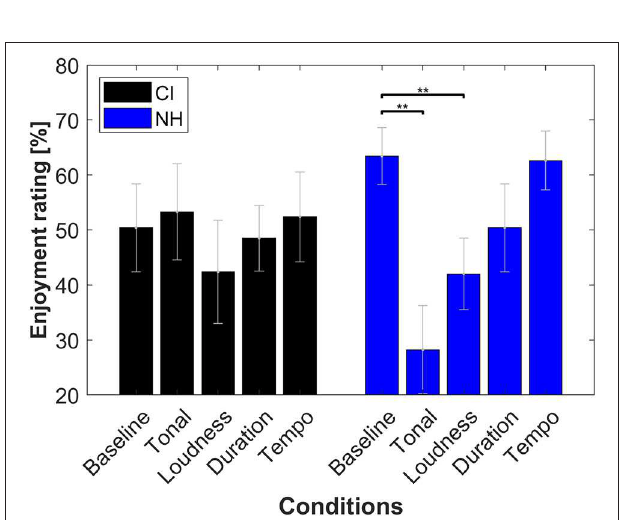
FIGURE 9 | Individual enjoyment ratings for each participant (represented by different colors). See details in Figure 7